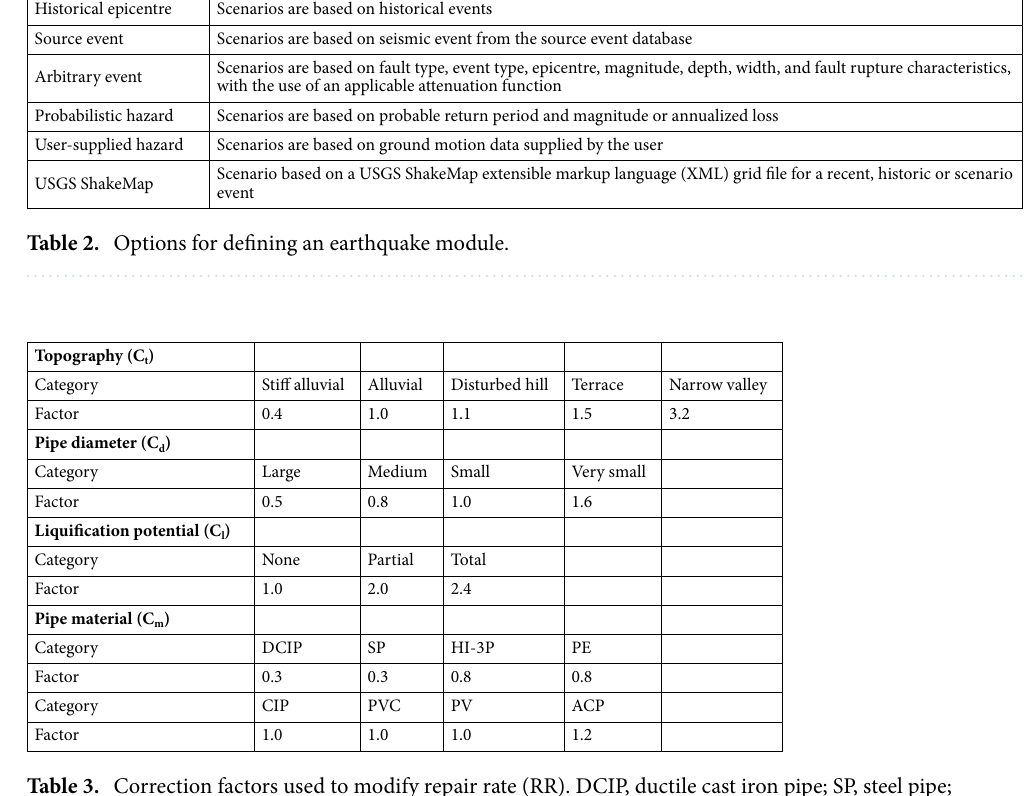
Table 3 and Eq. 5 display the correction factor and their categories and weights adopted from Isoyama et al. 42